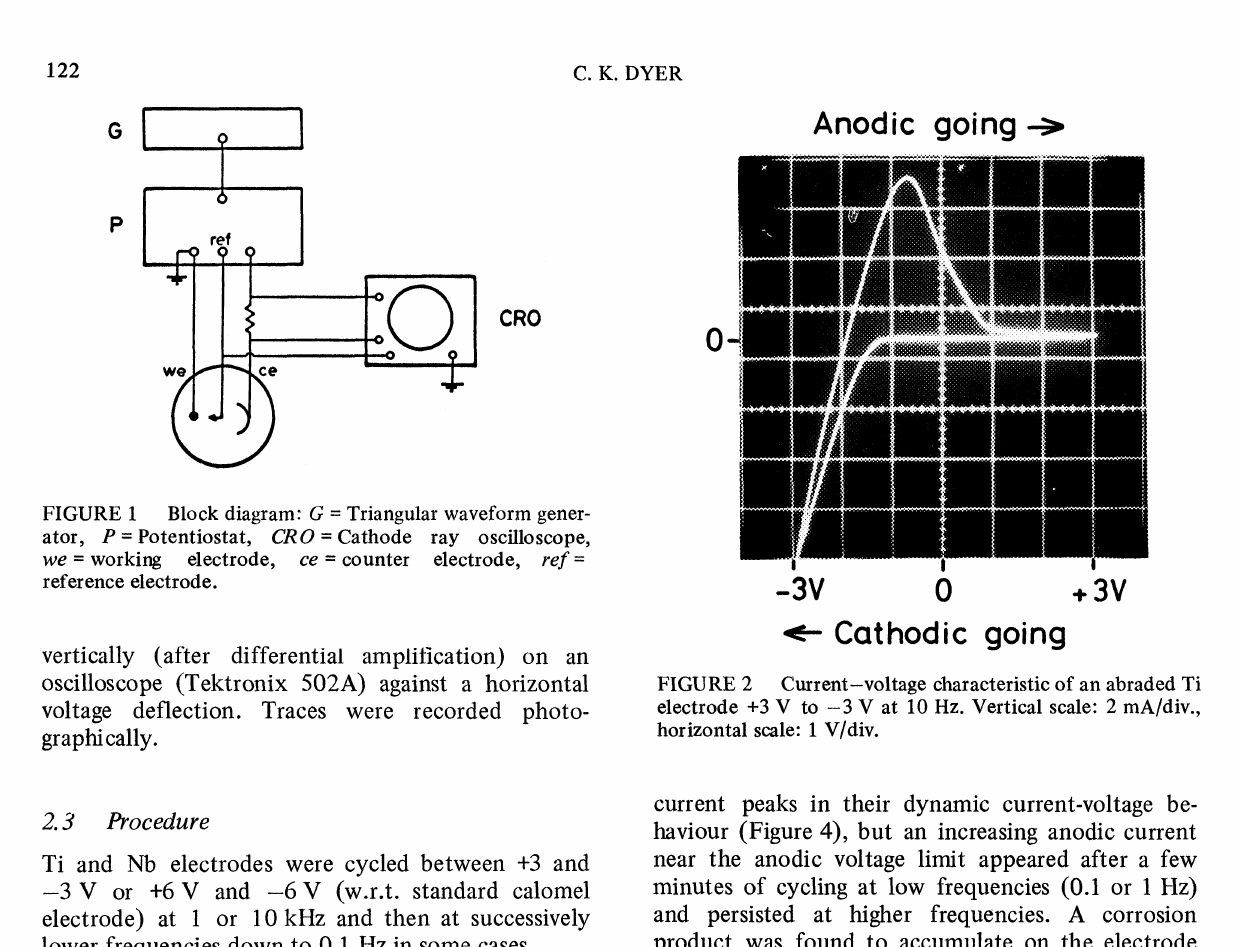
- 0 /3V Cathodic going FIGURE 2 Current-voltage characteristic of an abraded Ti electrode +3 V to -3 V at 10 Hz. Vertical scale: 2 mA/div., horizontal scale: V/div. Hz) 0 FIGURE 3 Abraded Ti electrode, +3.1 V to -3.1 V, 0.1 Hz. Vertical scale: 0.4 mA/div., horizontal scale: